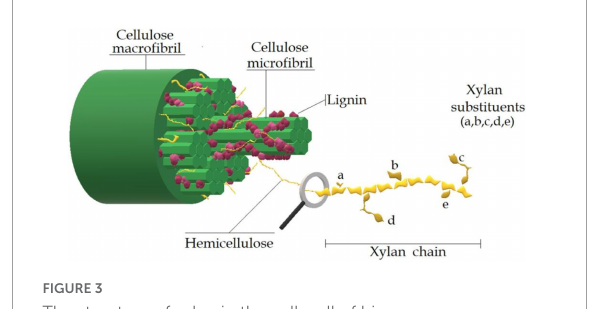
FIGURE3 The structure of xylan in the cell wall of biomass.